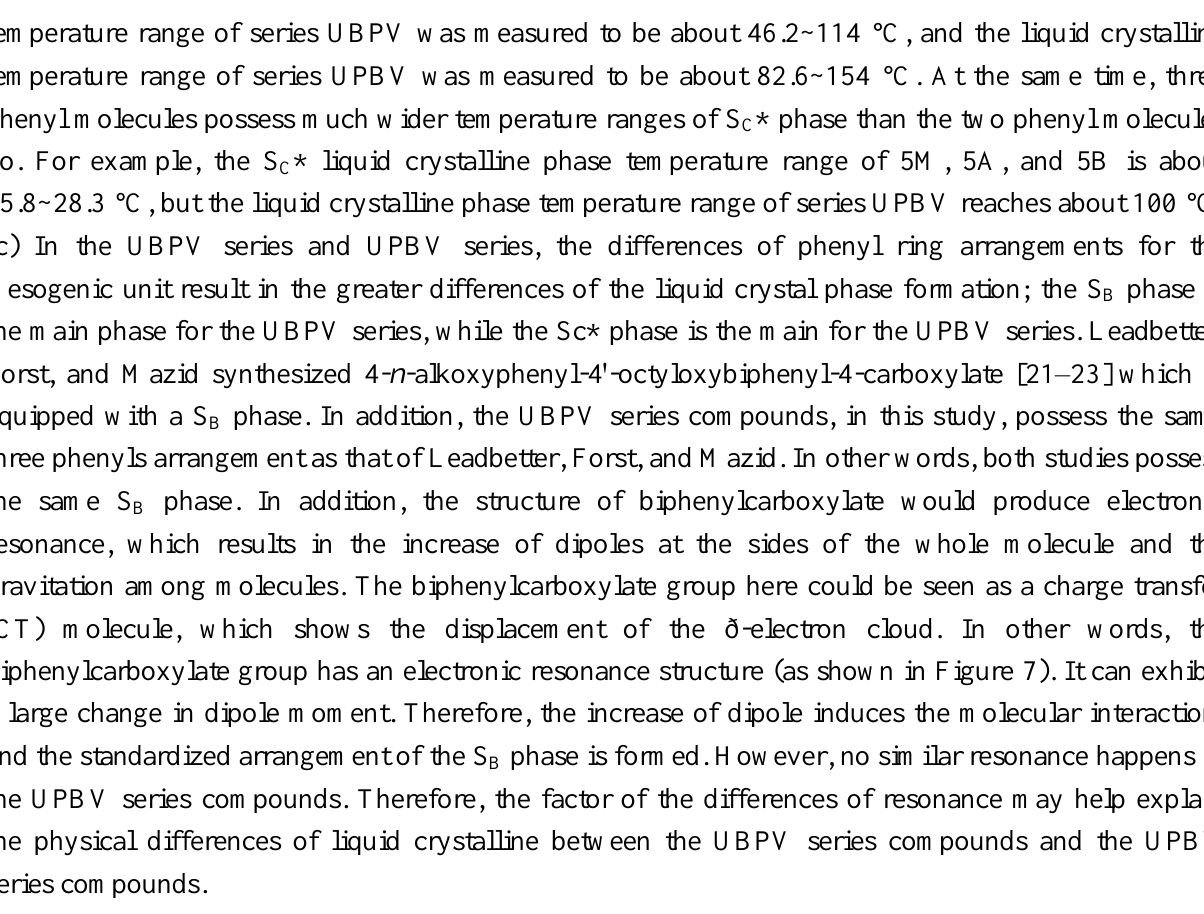
Figure 5. Liquid crystal temperature ranges of 5M, 5A, 5B a , UBPVs, and UPBVs.